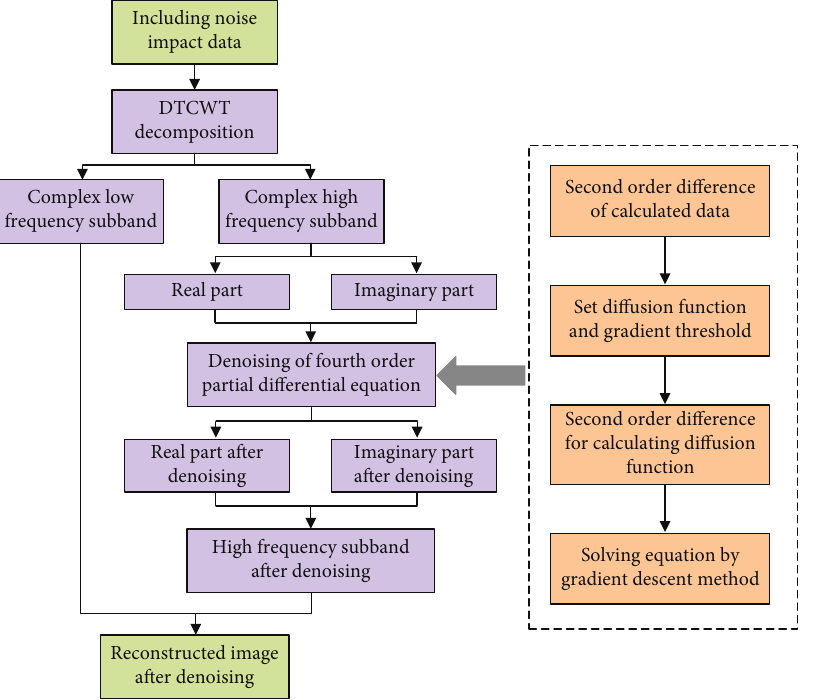
Figure 5: Flow chart of FD-DTCWT remote sensing image big data denoising